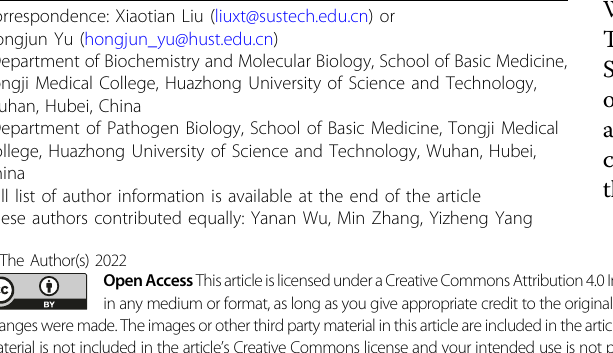
NikZ, to a resolution of 2.9 Å with an imposed C2 symmetry (Fig. 1e; Supplementary Figs. S1, S2 and Table S1). Two NikZ molecules, 40 lipid alkyl chains and 2 phospholipids were identi fi ed in the structure. Unsolved regions include N-terminal residues (1 – 377) and three short loop segments (residues 699 – 703, 897 – 907, 1076 – 1084). The Chs1 dimer measures ~100 Å × 100 Å × 50 Å. Each Chs1 protomer contains an N-terminal cytoplasmic domain (residues 378 – 783) and a C-terminal transmem- brane domain (residues 784 – 1131) (Supplementary